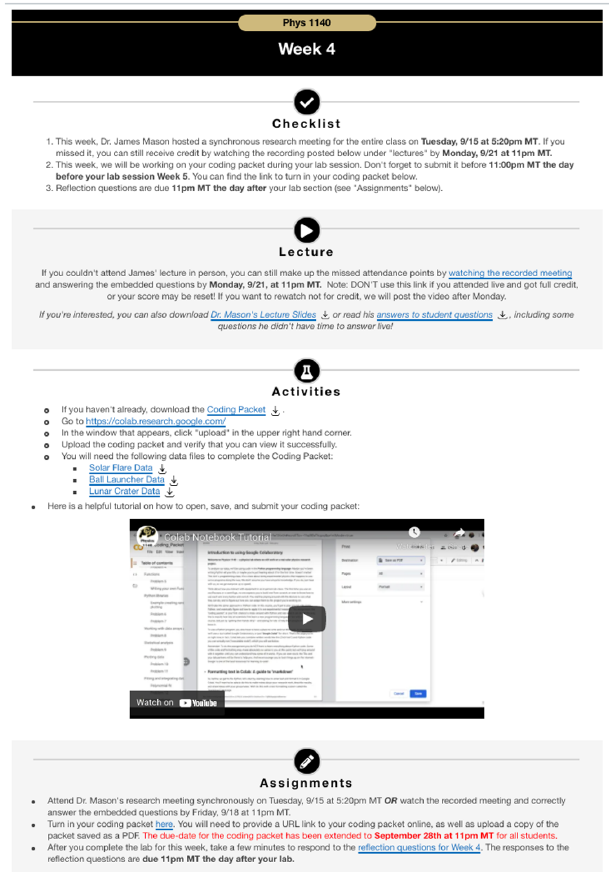
FIG. 2. An example of one of the weekly pages on Canvas showing the checklist of tasks, details about accessing the lecture, downloadable materials for the lab activities, and a list of assignments to be turned